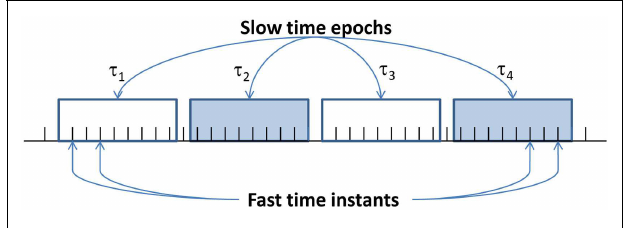
FIGURE 1 | Notion of two-time-scale dynamics .